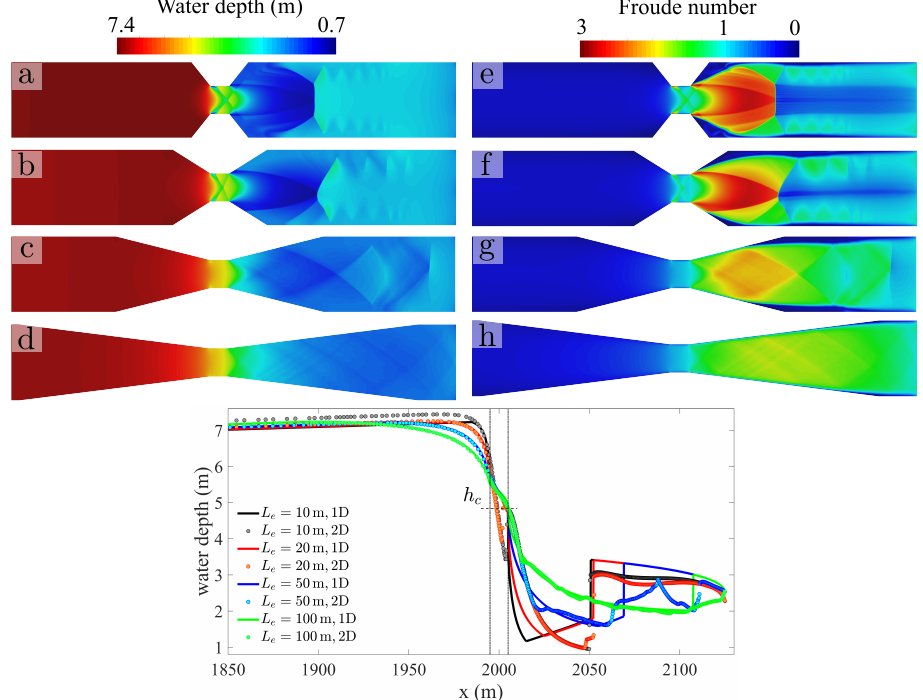
Figure 18. Role of the contraction geometry on the emergence of spatial flow patterns. We show maps of water depth (panels a – d ) and Froude number (panels e – h ), for the same flow conditions of Figures 3, 16 and 17, with L d = 125 m, and several values of the length of the expansion zone, L e = 10,20,50, and 100 m. For a smooth transition, L e = 100 m, the 1D theory captures the gradually varied water surface profile remarkably well. Two-dimensional effects dominate the flow for the sharpest contraction ( L e = 10 m, panels a and e ): while the location of the hydraulic jump seems to be correctly predicted by the 1D theory, the overall structure of the water surface downstream from the expansion zone. The abruptness of the expansion and contraction segments affects the Froude number in the expansion zone and downstream from it, illustrating the strong flow-focusing effect of an abrupt change in channel